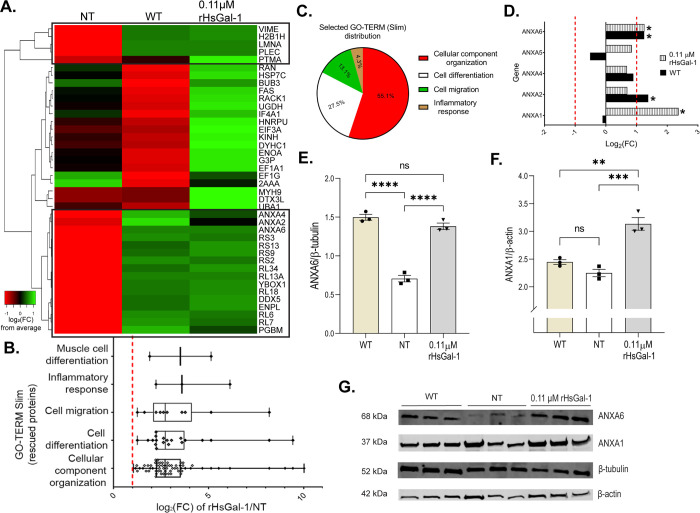
Shotgun proteomic analyses (MS/MS) of AJ WT, AJ-/- NT and 0.11 μM rHsGal-1 treated myotubes.A. Heatmap of top 20 and bottom 20 expressed proteins for WT myotubes based on Log2 fold change (FC) from the mean value all conditions. Box denotes cluster of proteins that had similar FC values between WT and rHsGal-1 treatment. B. GO-Term Slim analysis of rescued proteins. C. Relative amount of proteins found in the selected GO-Terms(B). D. Log2FC of Annexin family proteins (calculated based on WT and Gal-1 FC from NT). E. Quantification of ANXA6 after 48h differentiation in WT, NT, and 0.11 μM rHsGal-1 treated myotubes. F. Quantification of ANXA1 after 48h in WT, NT, and 0.11 μM rHsGal-1 treated myotubes. G. Western blot images of ANXA1 and ANXA6. p values were measured by 2-way ANOVA multiple comparison test and indicated by *p< 0.05, **p< 0.01, and ***p< 0.001. Error bars represent SEM. n = 3. All proteins were preselected based on protein ID significance values of ≥20% (p≤ 0.01, FDR≤0.05).